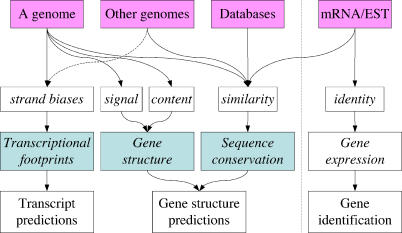
A Third Basic ConceptBy studying various sources of sequence information (pink boxes), genes have been identified using a variety of computational methods based on the identification of gene structure and/or the identification of sequence conservation. The FEAST methods represent a third basic concept, in which sustained transcriptional activity is inferred by its mutational and selective effects on the genomic sequence, the “transcriptional footprints.” Light blue boxes indicate the three basic concepts for gene prediction. The dashed vertical line separates gene prediction (to the left), from gene identification (to the right): the latter is based on the analysis of sequences expressed from the same locus.